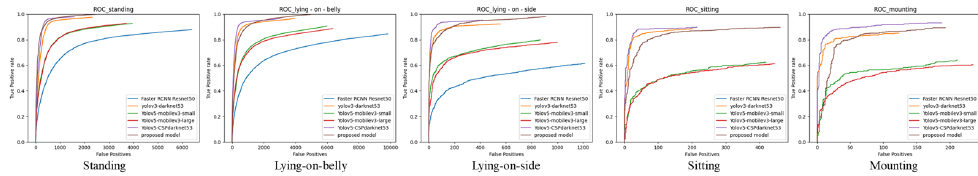
Figure 11. ROC curve for each category (standing, lying-on-belly, lying-on-side, sitting, mounting). Third, our application of posture detection was only used for weaned piglets.